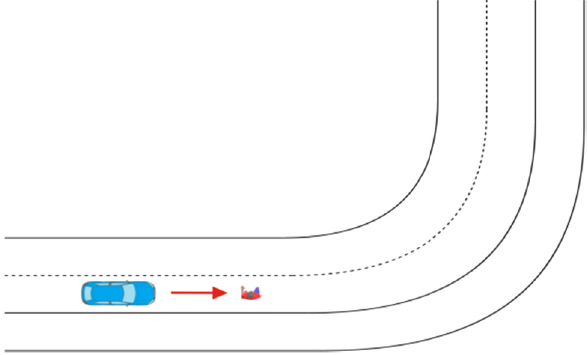
Figure 10: Research situation in test 2. Source: “ authors ” own